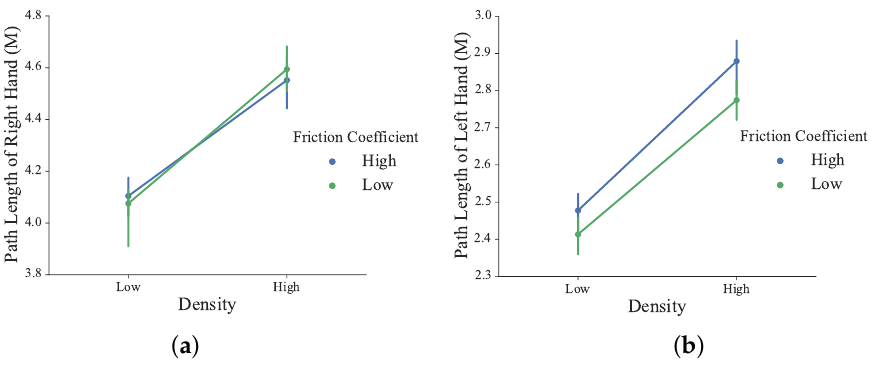
Figure 15. ( a ) Path length of the right hand; ( b ) Path length of the left hand during the task.